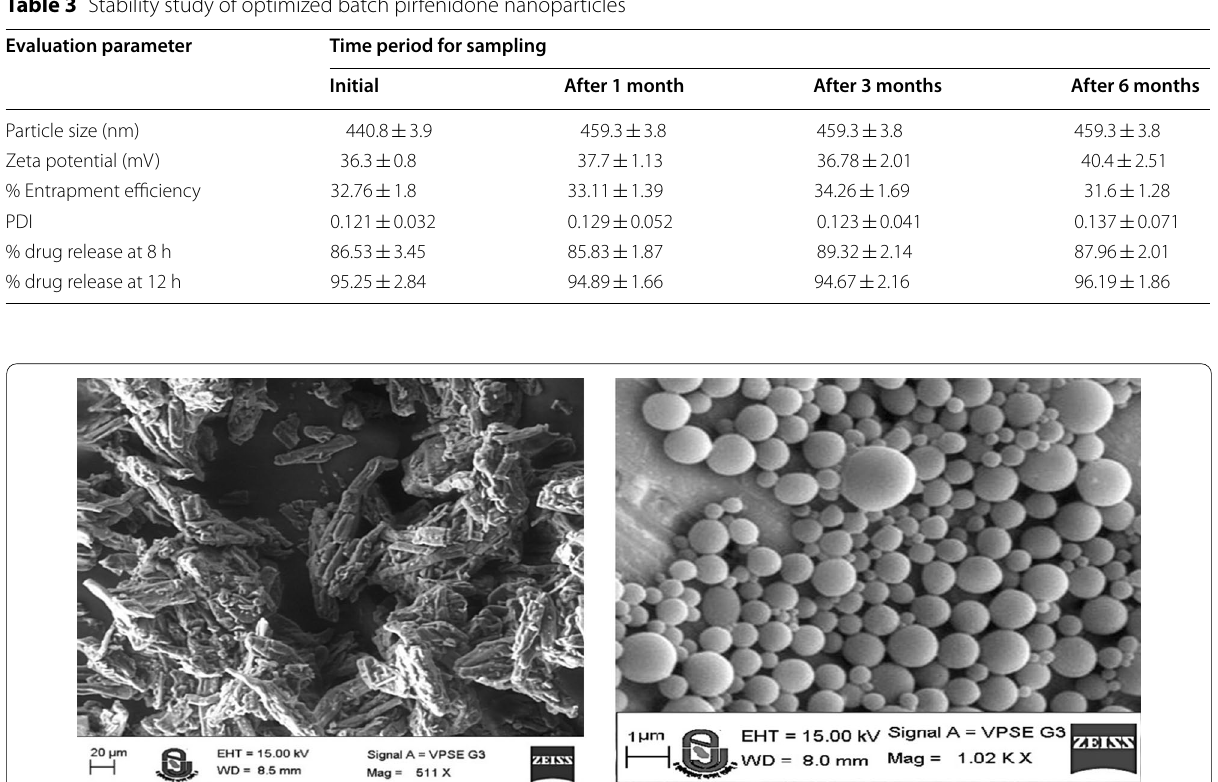
Fig. 8 a Surface morphology using SEM of raw pirfenidone drug powder b Surface morphology using SEM of pirfenidone nanoparticles (optimized batch)